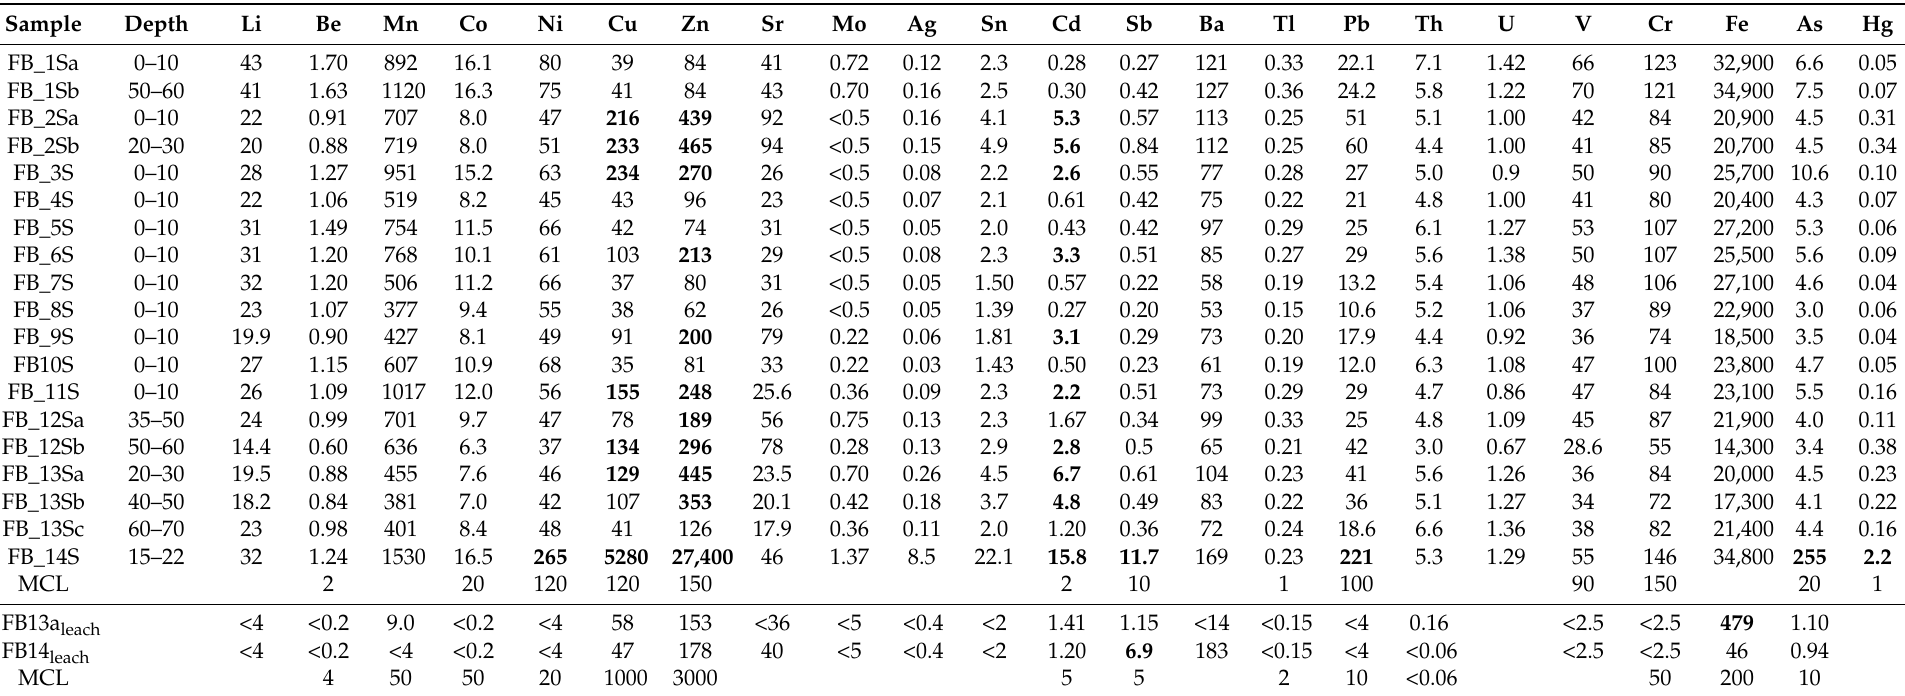
Table 1. Trace element concentration in Fornaci di Barga soils (mg/kg) and in soil leachates ( µ g/L) from FB_13S and FB_14S samples) together with the maximum concentration level (MCL, mg/kg) imposed by Italian regulations (Legislative Decree No. 152/2006 approving the Code on the Environment). Values in bold exceed the MCL for residential soil use or groundwater in case of